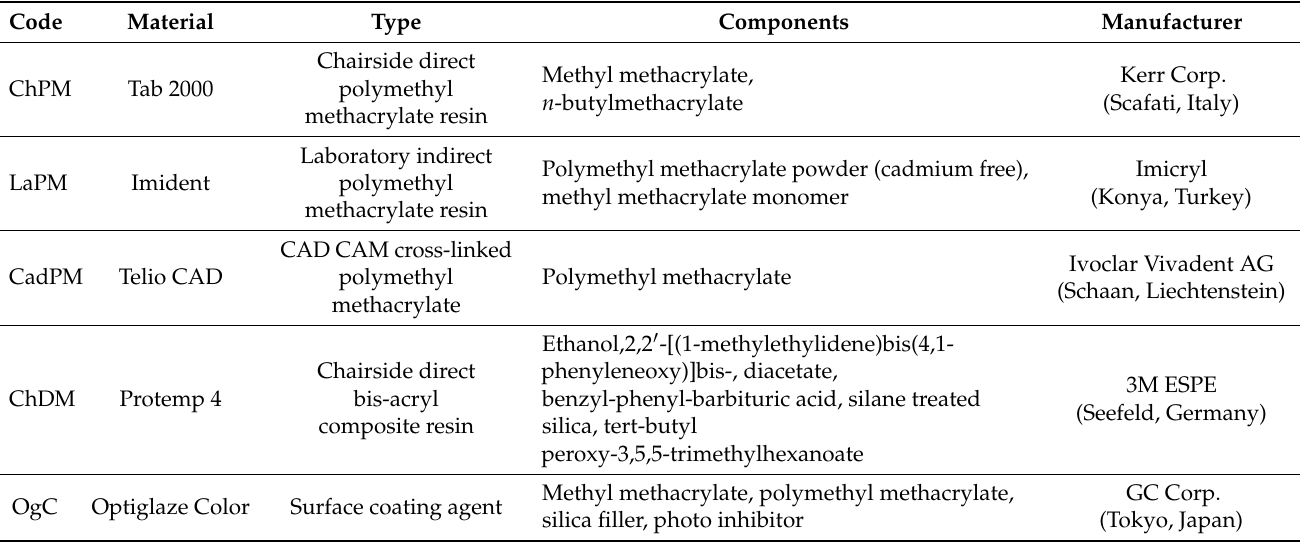
Table 1. Materials used in the